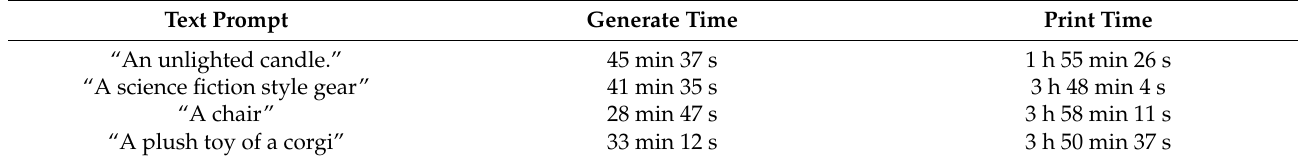
Table 4. Some examples of 3D content generation based on text prompt.